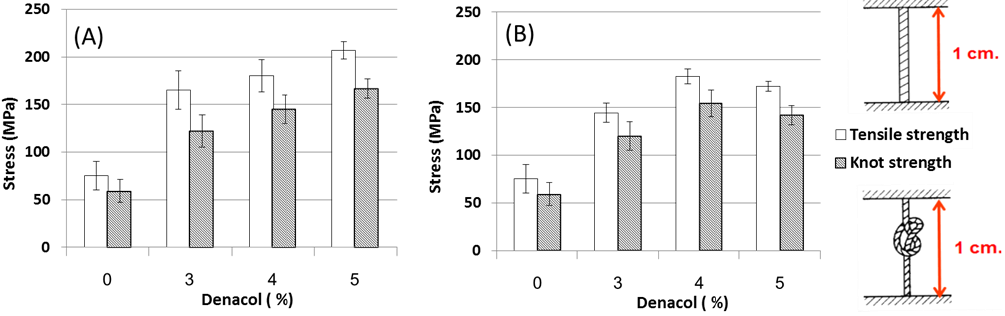
Figure 5. Mechanical strengths of denacol-crosslinked fibers: ( A ) no heat treatment and ( B ) heat treatment at 100 °C for 24 h.